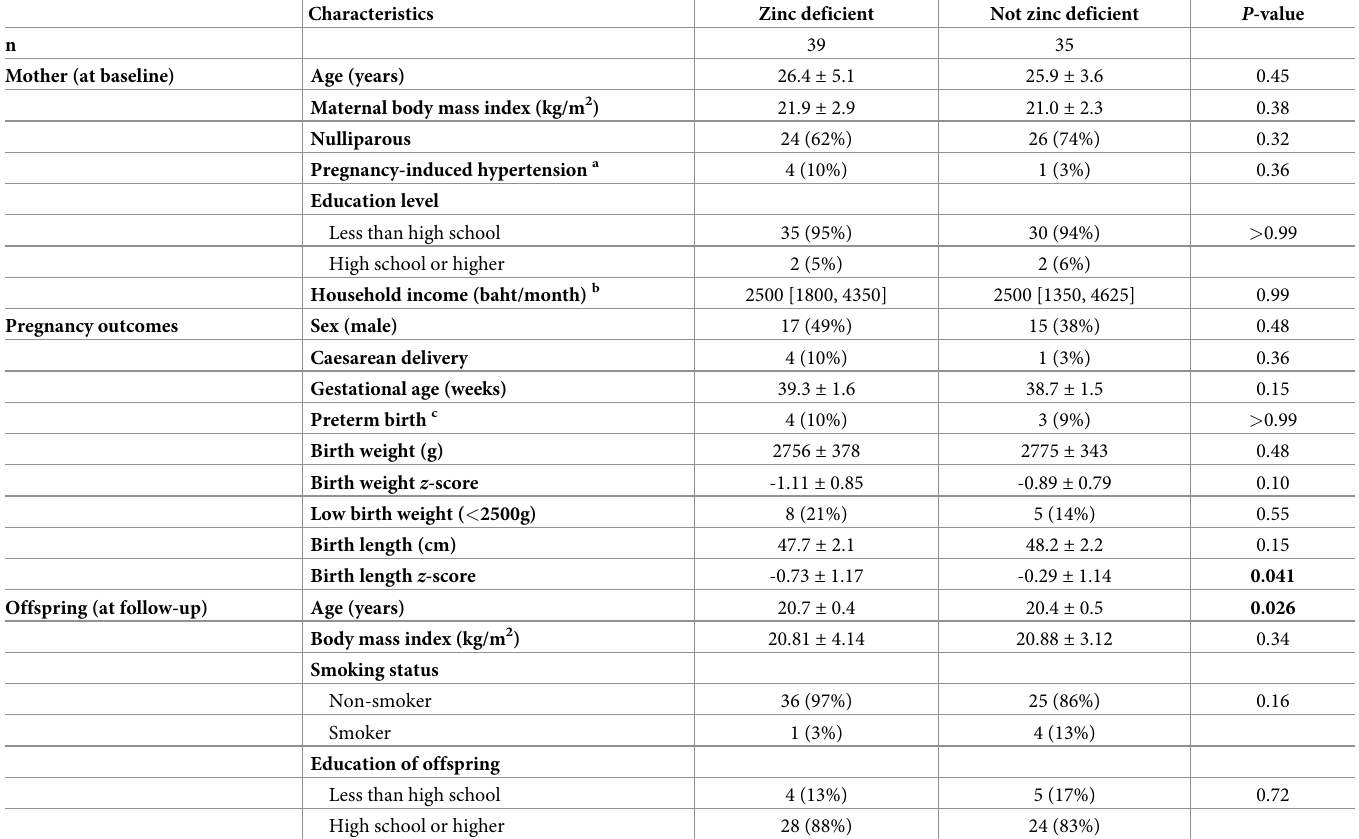
Table 6. Demographic characteristics of study participants according to maternal zinc status in late